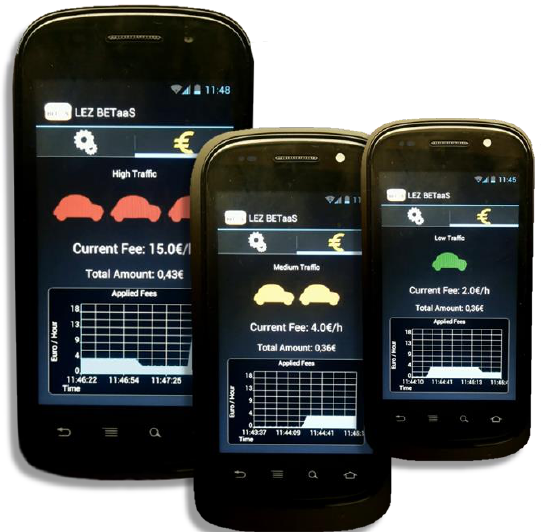
Figure 3. Screen shot of LEZ BETaaS mobile apps